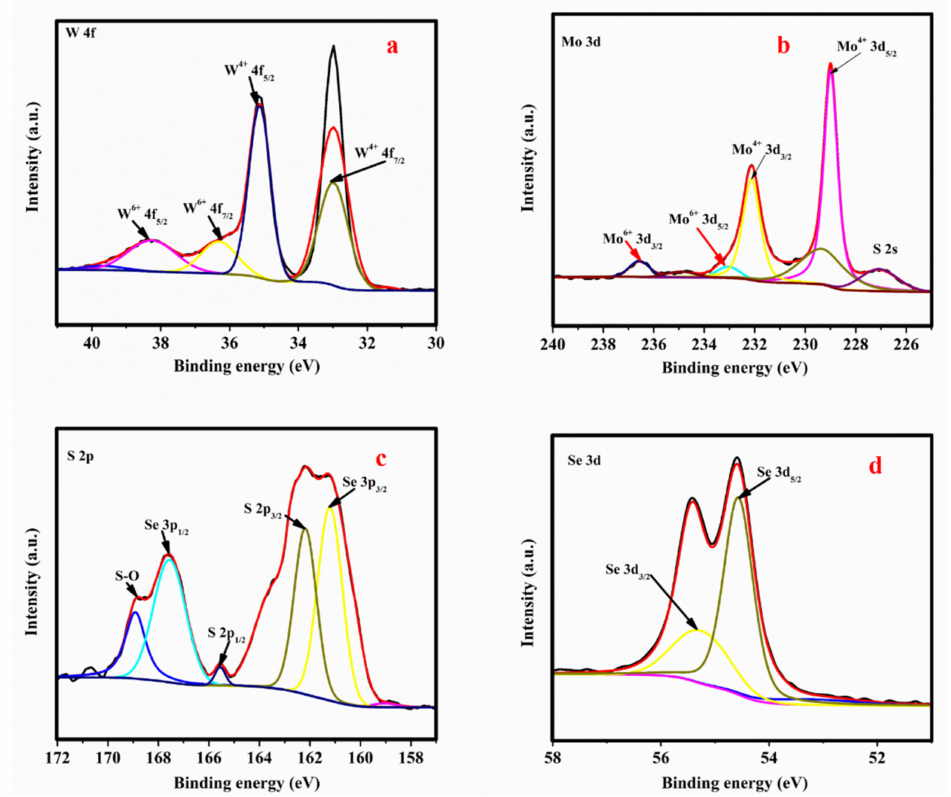
Figure 3. XPS elemental profiles of ( a ) W, ( b ) Mo, ( c ) S, and ( d ) Se elements of the MoSe 2 -WS 2